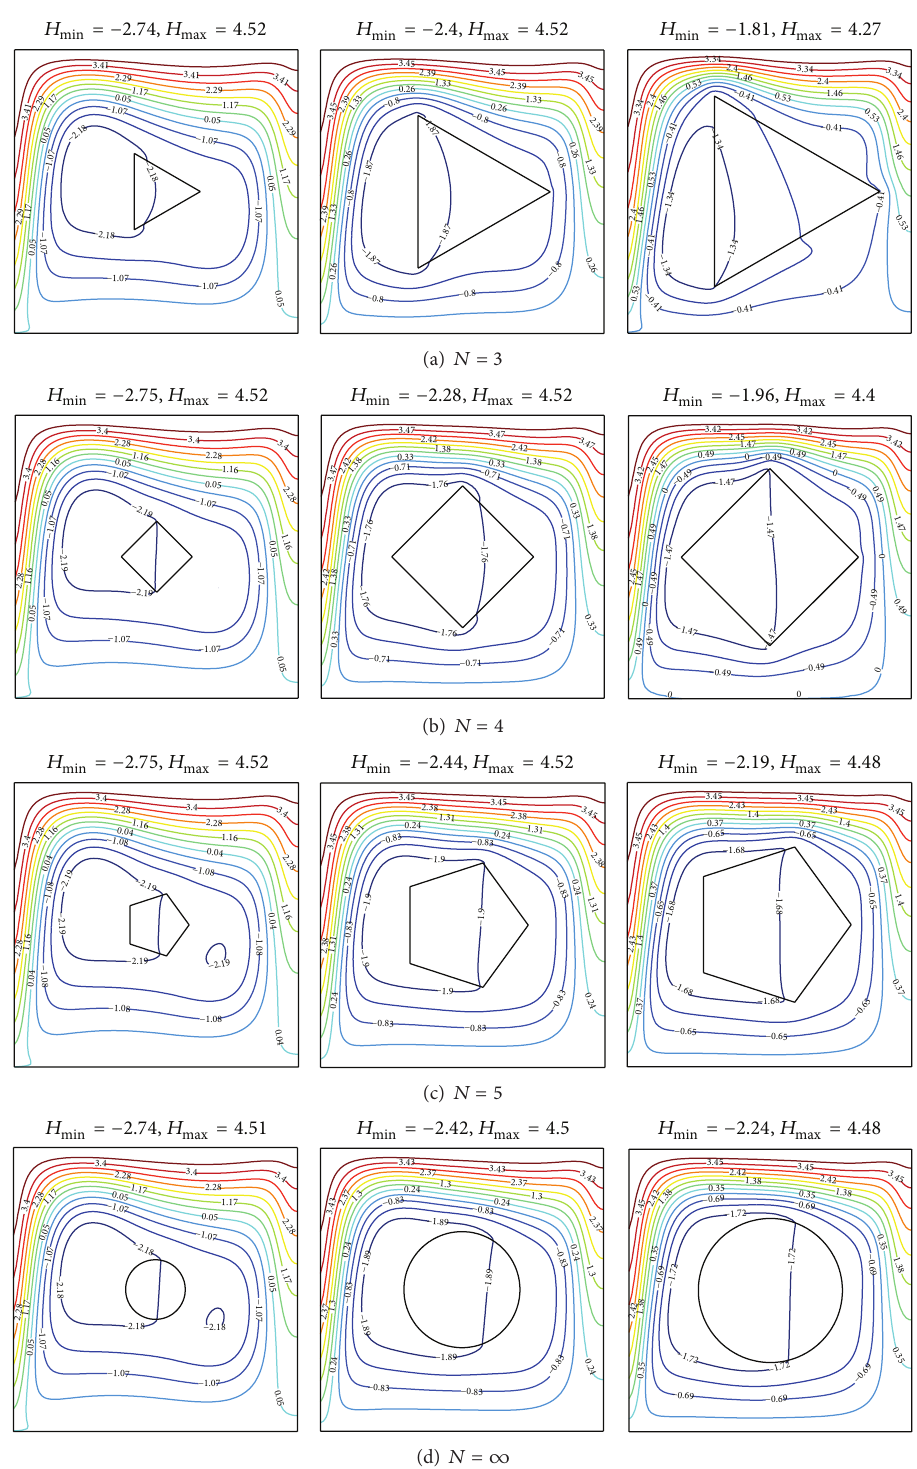
Figure 4: Heatlines for different polygons to enclosure area ratio 𝐴 and number of polygon sides 𝑁 at 𝐾 𝑟 = 1.0 , 𝑋 0 = 0.5 , and Ra = 10 5